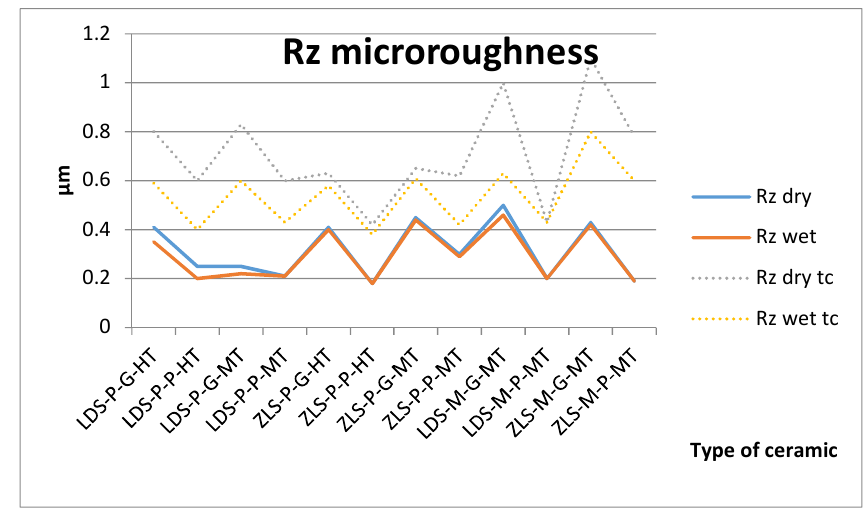
Figure 2. Absolute vertical roughness (Rz) microroughness values for all tested samples, dry and wet, before and after thermal cycling (tc).